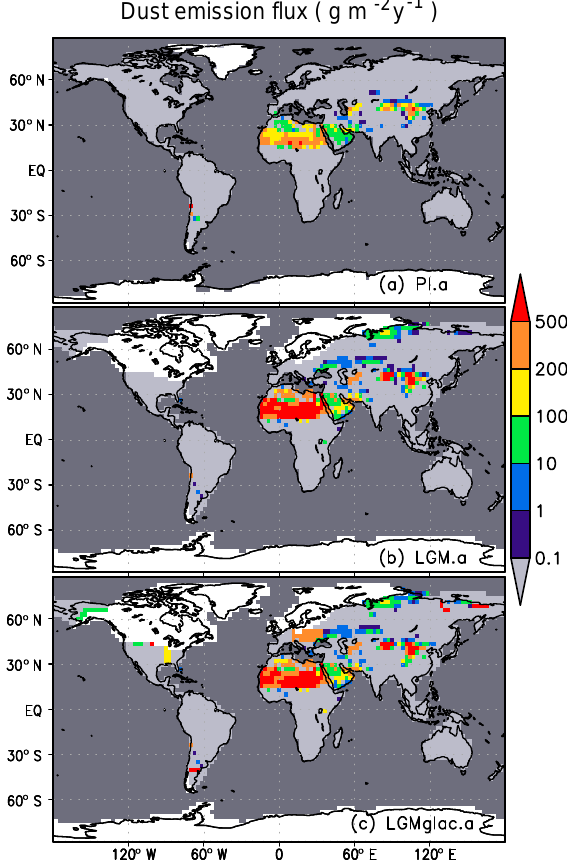
Figure 3. All panels are zonal mean height plots. Ratio of the dust mass concentration for (a) LGM.a / PI.a, (b) LGMglac.a / PI.a, and (c) temperature change for LGMglac.a–LGM.a. Contour lines in (a) and (b) show the dust mass concentration for PI.a (gcm − 3 ) and in (c) the temperature change for LGM.a–PI.a ( ◦